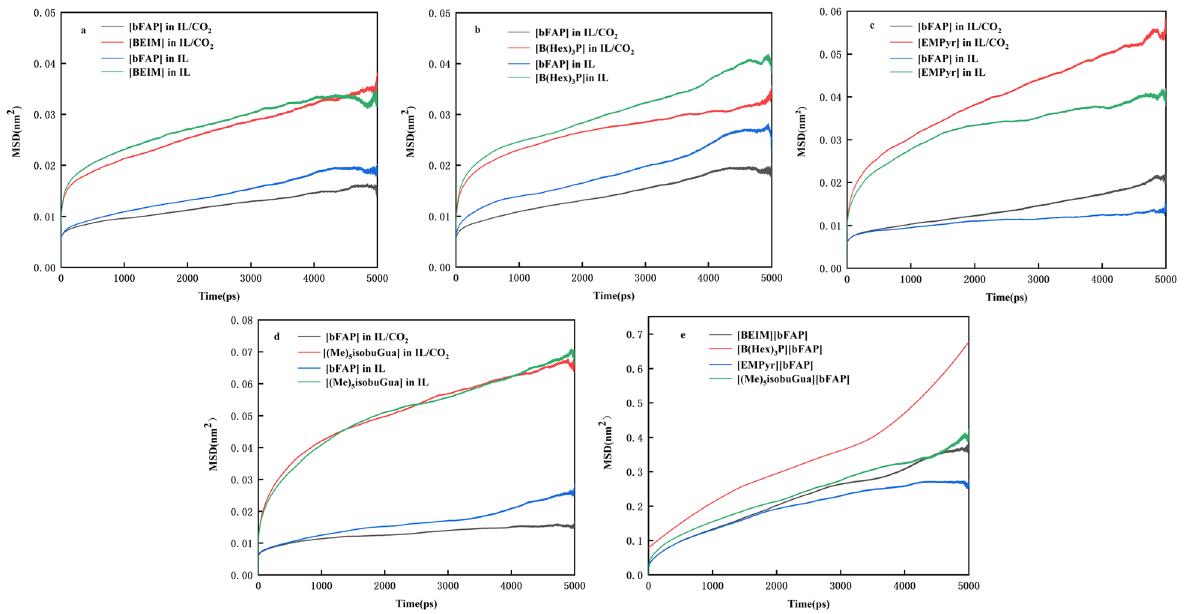
Figure 4: Comparison of the mean square displacement of of cations, anions, and CO 2 in IL and IL/CO 2 at 298 K: ( a ) [ BEIM ] and [ bFAP ] in pure [ BEIM ][ bFAP ] , ( b ) [ B ( Hex ) 3 P ] and [ bFAP ] in pure [ B ( Hex ) 3 P ][ bFAP ] , ( c ) [ EMPyr ] and [ bFAP ] in pure [ EMPyr ][ bFAP ] , ( d ) [( Me ) 5 isobuGua ] and [ bFAP ] in pure [( Me ) 5 isobuGua ][ bFAP ] , and ( e ) CO 2 in the four ILs.